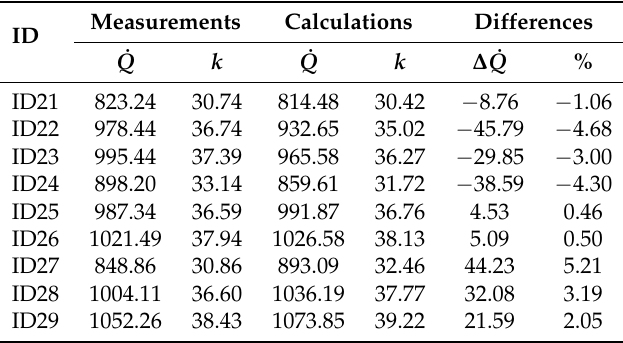
Table 12. Comparison of measurements and analytical calculations with the modified correlation. Measurements Calculations ID